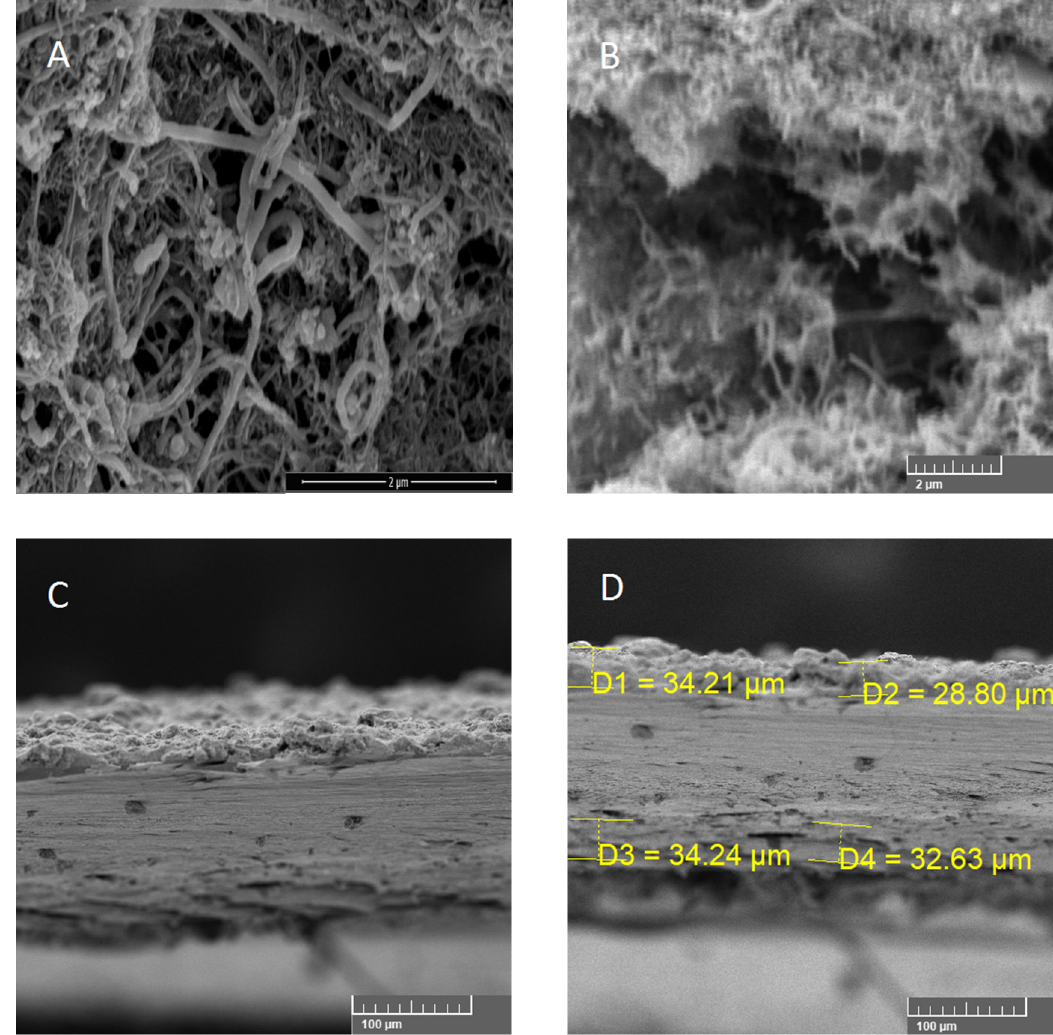
Figure 2. SEM pictures of prepared PU/MWCNT composite. ( A ) surface of PU/MWCNT composite. ( B ) cross section of prepared composite (upper part) ( C ) cross section of PU/MWCNT composite on PET foil. Double side coating. ( D ) Cross section of PU/MWCNT composite with measured thickness (denoted D1–D4).